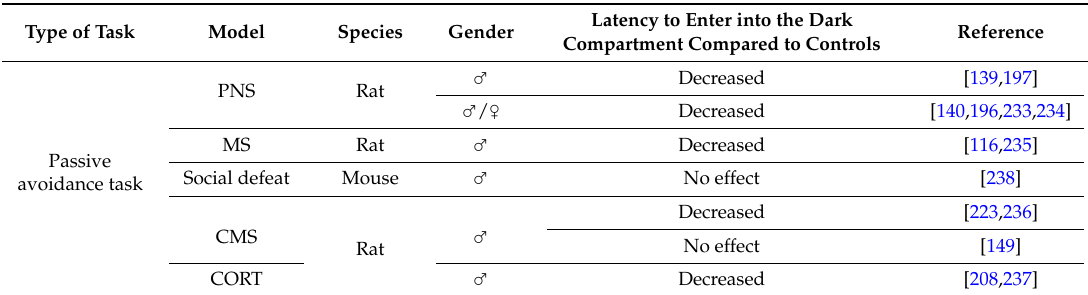
Table 8. Associative memory performances in passive avoidance task in different rodent models of